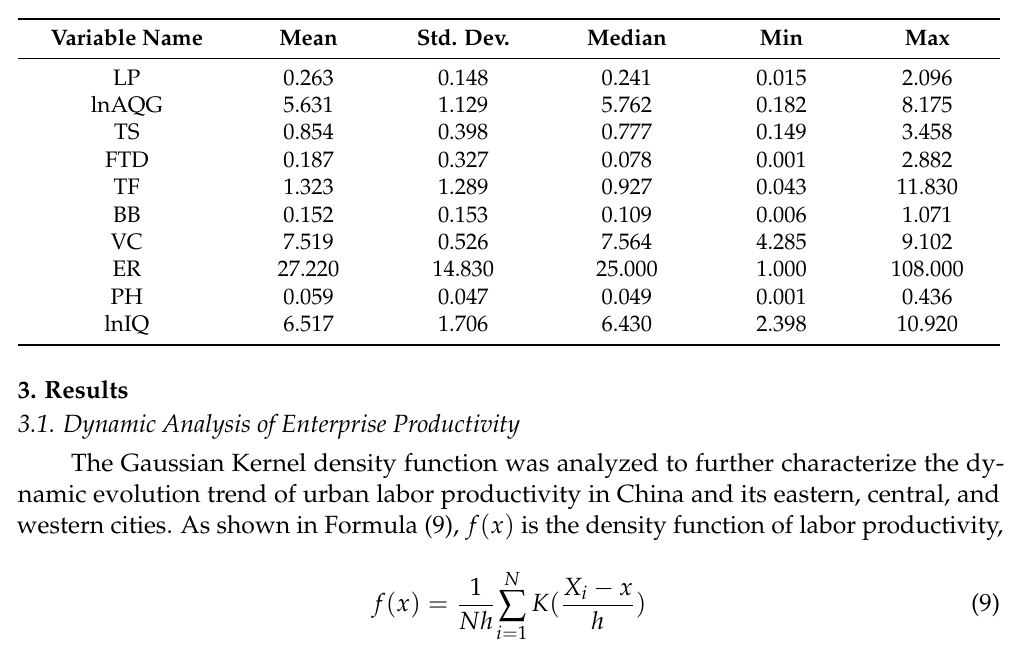
Table 1. Statistical description of